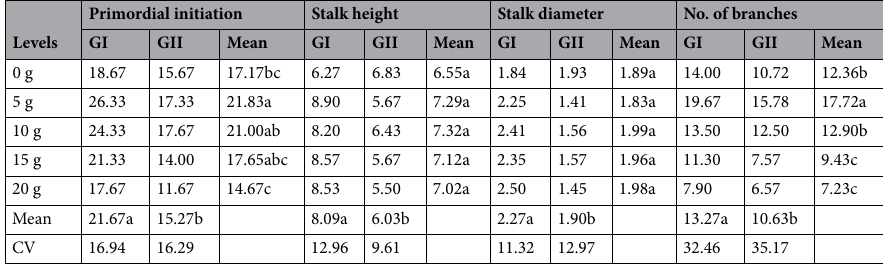
Table 1. Effects of genotypes and limestone levels on growth attributes of the mushroom. Means with the same letter are not significantly different at P = 0.05. LSD 0.05 for comparing two spawn genotypes means = 2.735. LSD 0.05 for comparing two lime means = 4.325. LSD 0.05 for comparing two spawn genotypes means = 1.960. LSD 0.05 for comparing two lime means = 3.098. LSD 0.05 for comparing two spawn genotypes means = 0.553. LSD 0.05 for comparing two lime means = 0.875. LSD 0.05 for comparing two spawn genotypes means = 1.708. LSD 0.05 for comparing two lime means = 2.700.